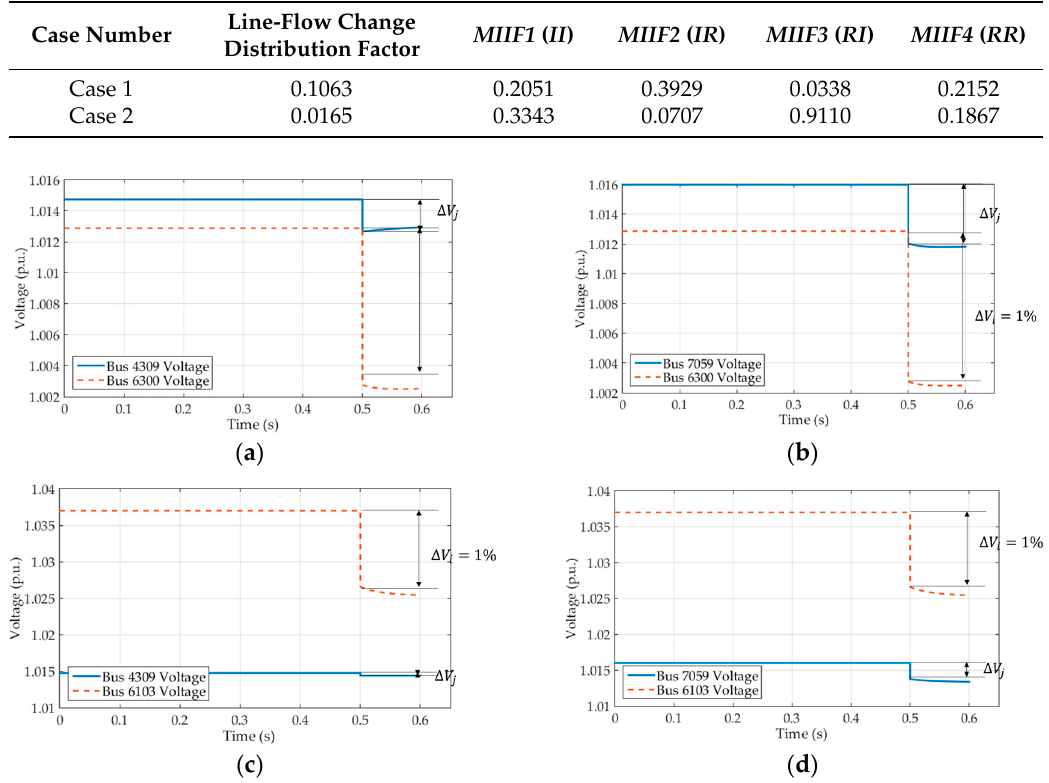
Table 3. Line-flow change distribution factor and MIIF calculation results for Korea power system.